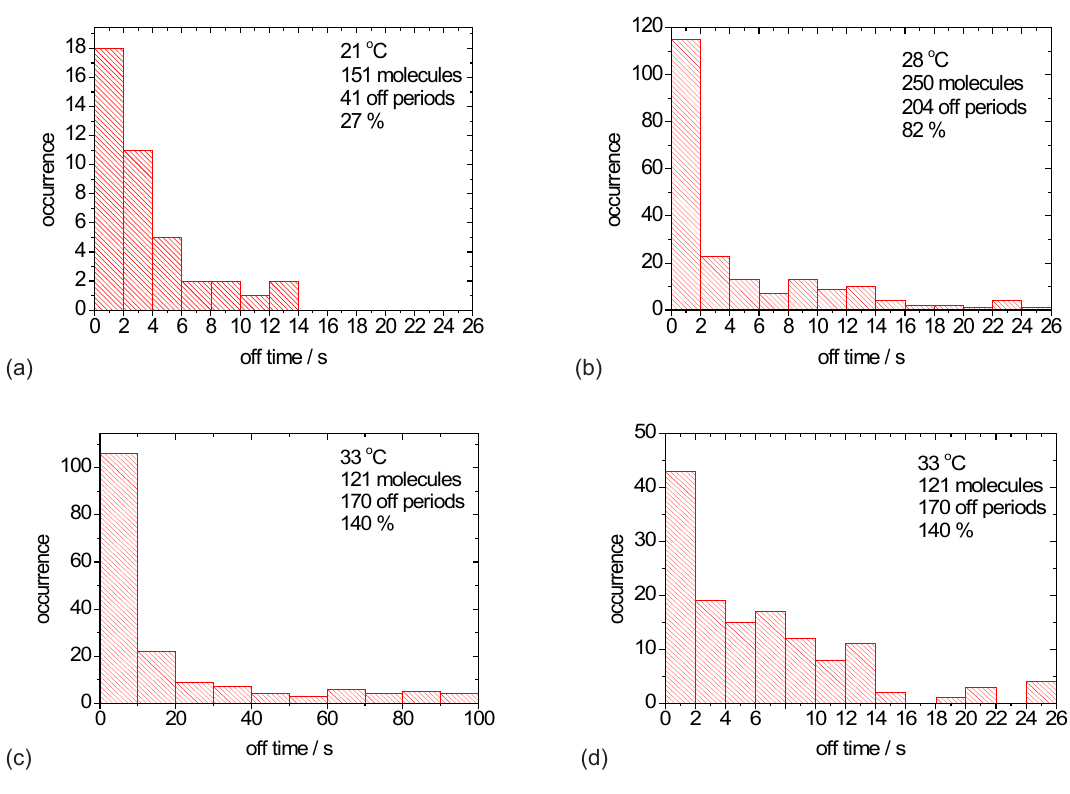
Figure 10. Histograms of single molecule off times at (a) 21°C, (b) 28°C and (c) and (d) at